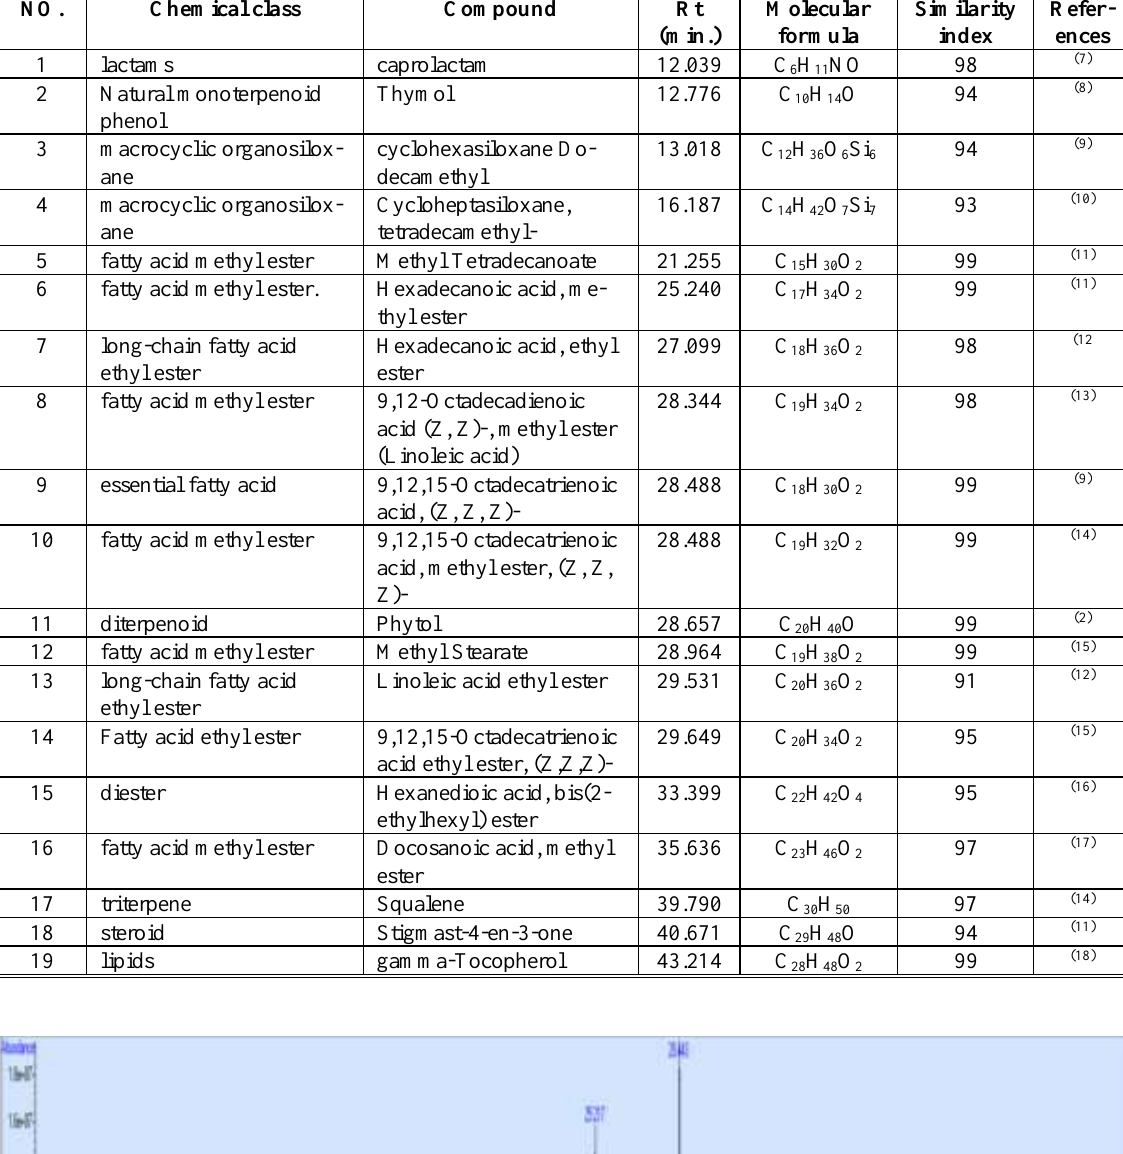
Table 4. GC-MS analysis of petroleum ether leaves extract of Leucaena leucocephala by hot extraction method.